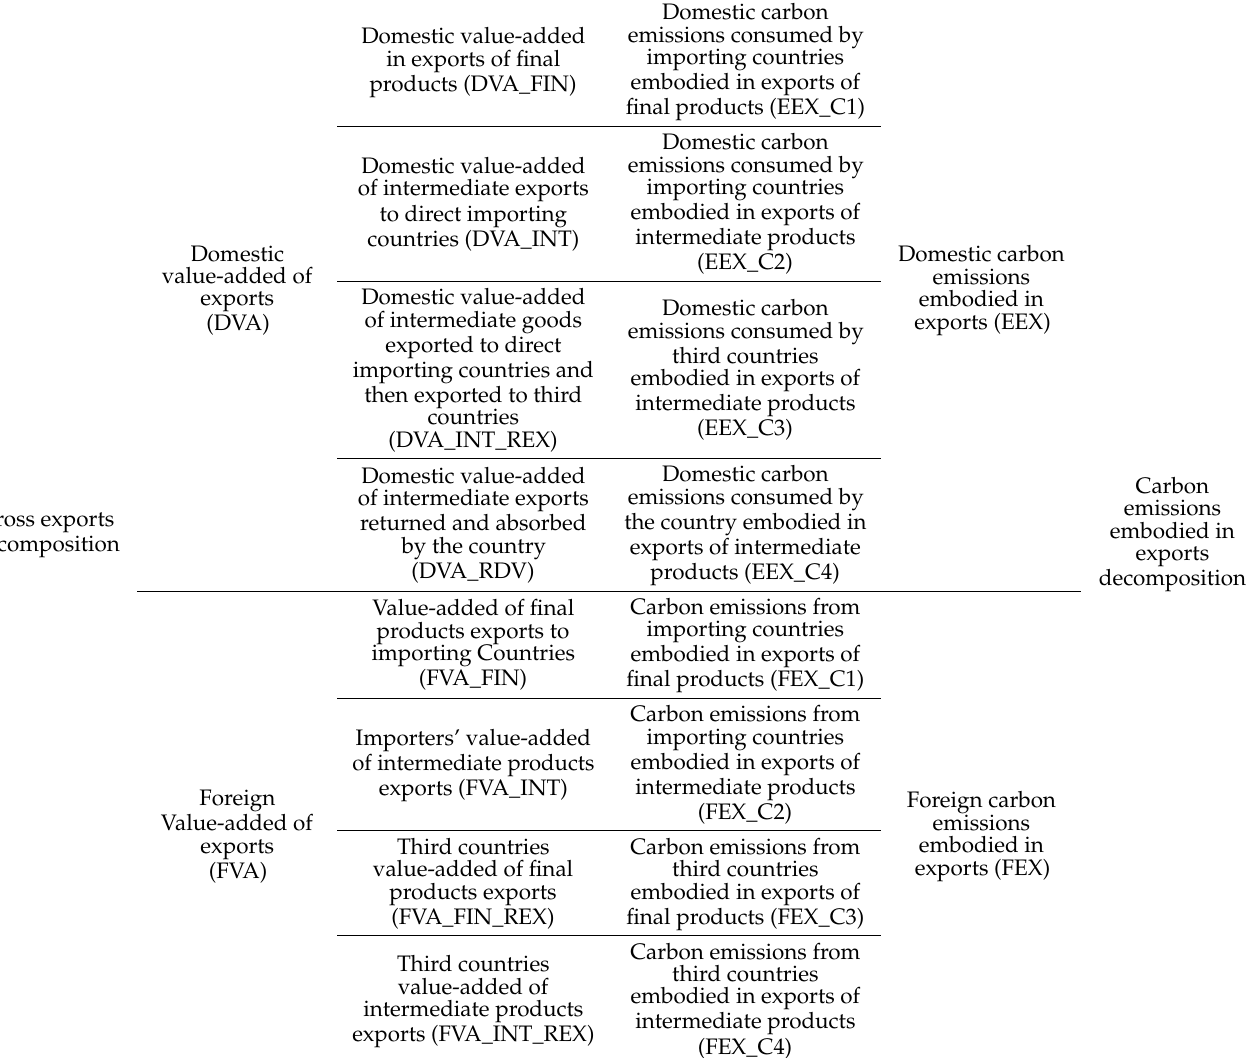
Table 1. Decompositions of value-added and carbon emissions embodied in